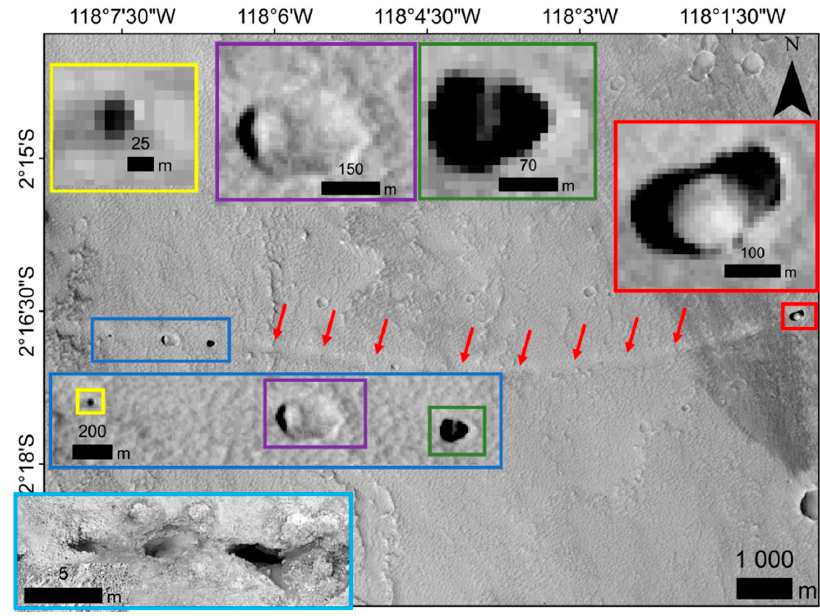
Figure 12. Multiple pit craters in the same lava channel (marked by red arrows) displaying various morphologies and dimensions (CTX Scene ID: J14_050313_1778_XI_02S118W). The red rectangle shows a pit crater with a visible mound in the middle. The blue rectangle highlights three craters separated by several kilometers. The subsidence structure within the green rectangle is a seemingly hollow pit crater, the one within the violet rectangle is the largest of the three but filled with debris, and the smallest of these structures is marked by the yellow rectangle. The inset figure within the cyan rectangle shows an analogous chain of small cave openings in our Icelandic study area. CTX image credit: NASA/JPL-Caltech.